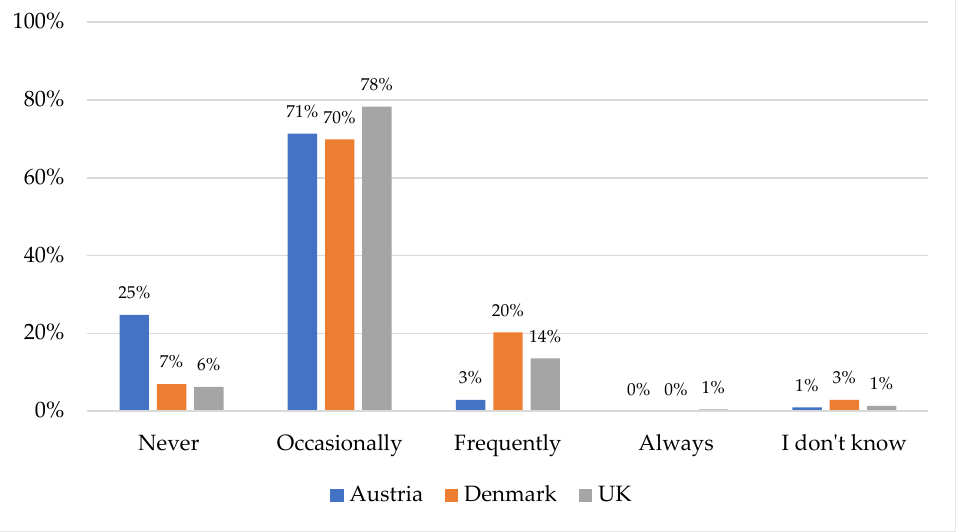
Figure 1. Percentage of clients questioning veterinarians’ professional advice based on information obtained from the internet for Austria ( n = 101), Denmark ( n = 172), and the UK ( n = 368).